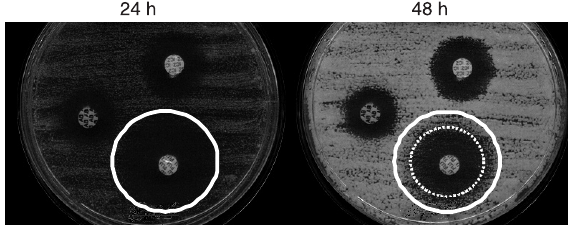
Figure 1. Representative culture of trailing growth observed in Candida albicans . Strain 11 was tested against fluconazole, amphotericin B and 5-fluorocytosine. The white circles show the characteristic trailing growth, which is defined as a resistant MIC after 48 h (dotted circle) of incubation with triazole antifungal agents but a susceptible MIC after 24 h (full circle), in the pres- ence of fluconazole after 24 and 48 h of incubation. The same re - sult was observed when itraconazole and all other trailing strains were tested (data not shown). Figure 2. Albumin degradation profiles from different strains of Candida albicans . ATCC strain 36802 and six trailing clinical strains (designated 2A, 9, 11, 44A, 44B, and 78) were grown in YCB medium supplemented with 0.1% BSA (as the nitrogen source) at 37°C under slight agitation. After 48 h of growth, the cultures were harvested and filtered and the spent culture media were then analyzed by SDS-PAGE to demonstrate the cleavage of soluble BSA. A control in which the culture medium was col- lected before the yeast inoculation is shown (lane BSA). The gel was silver-stained and the numbers on the left indicate the rela- tive molecular mass of standards, reported in kilodaltons (kDa).